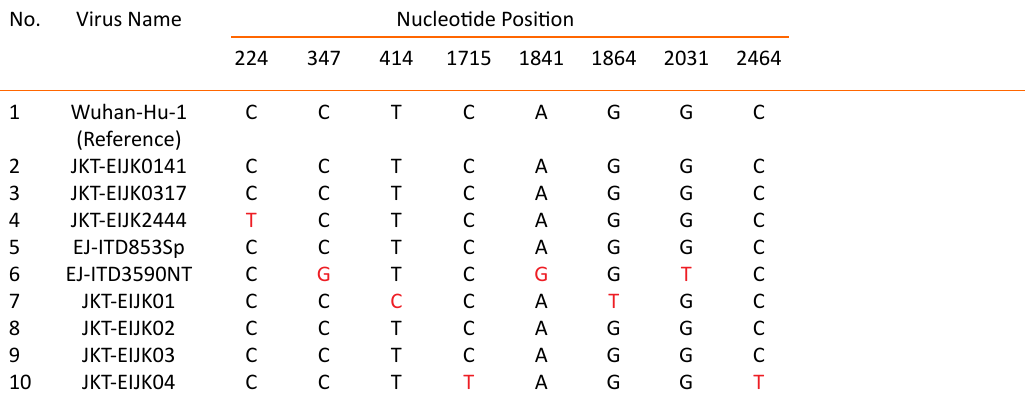
Table 2. Nucleotide mutation sites in the SARS-CoV-2 spike glycoprotein No.